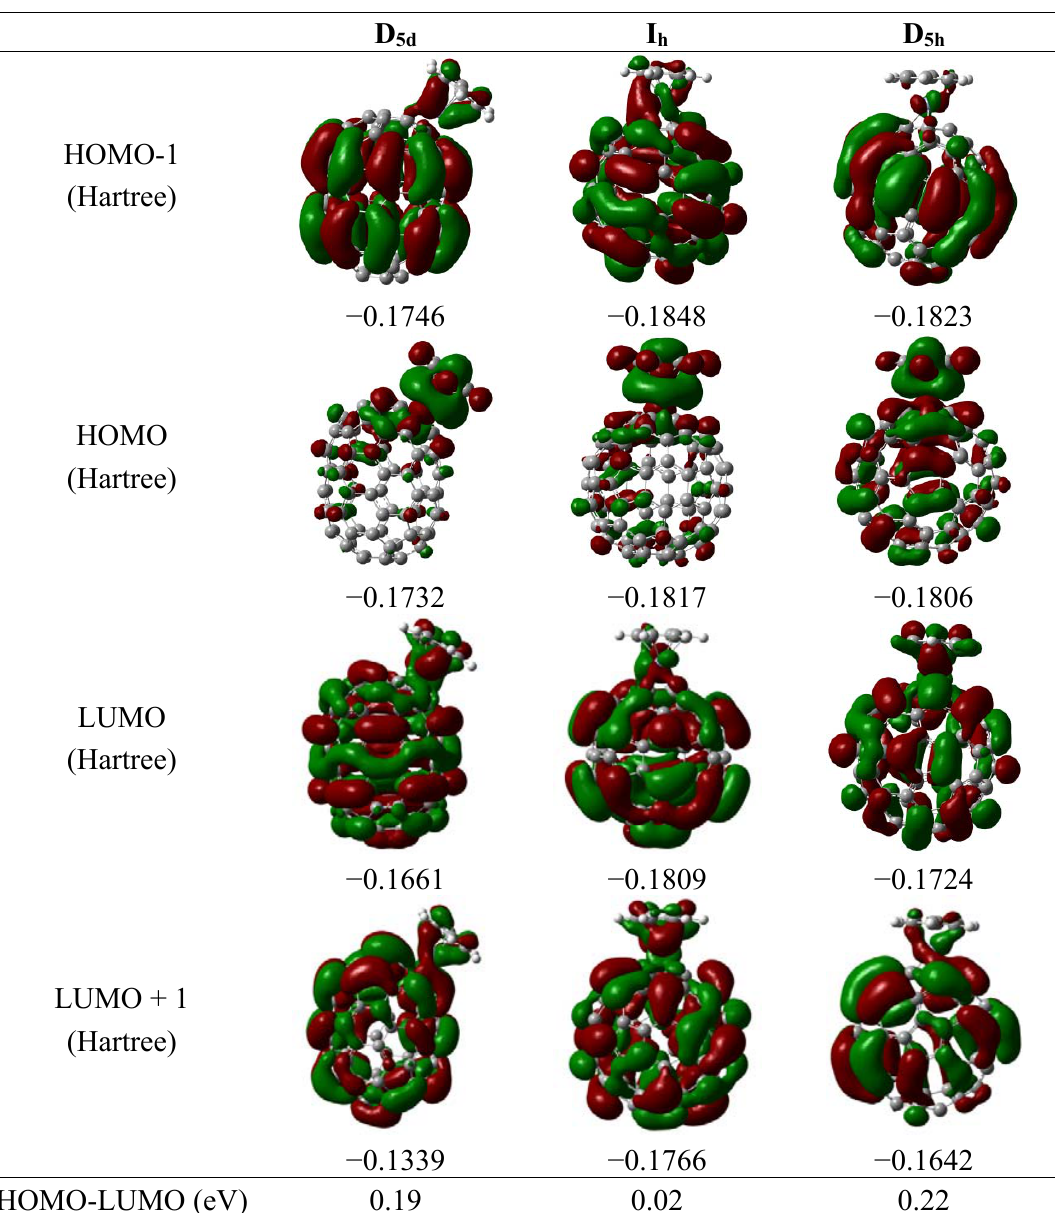
, I and D 5d h 5h